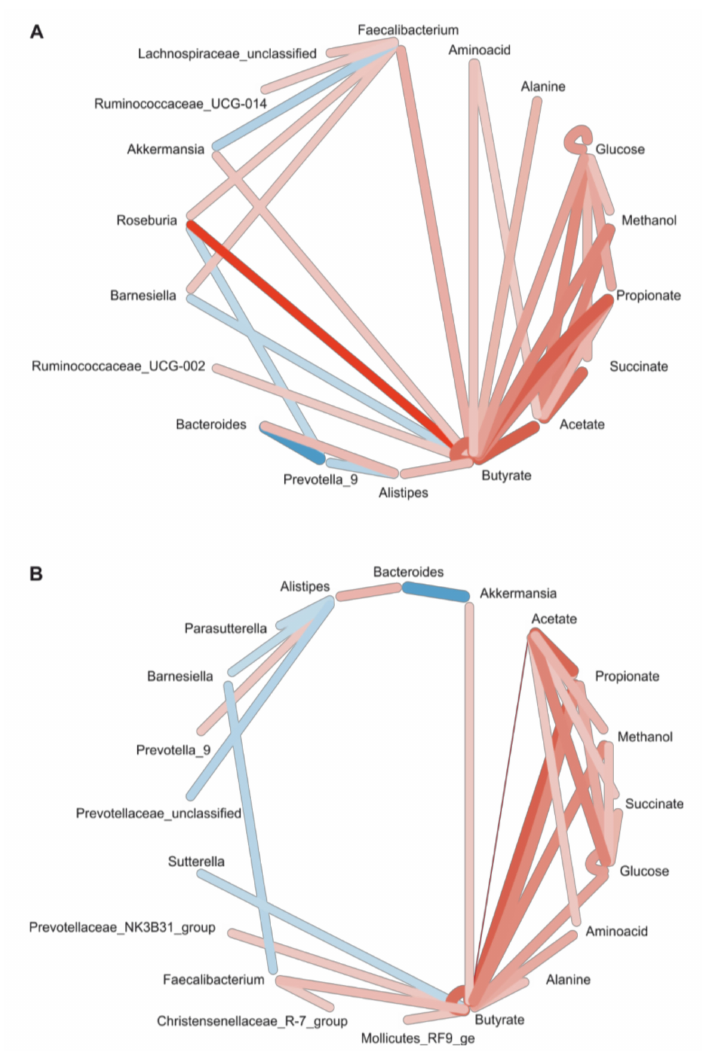
Figure 6. Correlation network of taxa and metabolites. Correlations between taxon abundance and peak intensities were calculated using SparCC and taxonomic abundance data ( A ) for the V3–V4 and ( B ) the V1–V3 region. Both regions reveal an interaction network centered on butyrate, with strong links between the SCFA as well as to certain taxa. In both datasets, Faecalibacterium was positively correlated with butyrate. Edge color = direction of interaction: red = positive; blue = negative; Edge weight = strength of interaction, i.e., correlation coe ffi cient; only interactions with a two-sided p -value of > 0.05 were